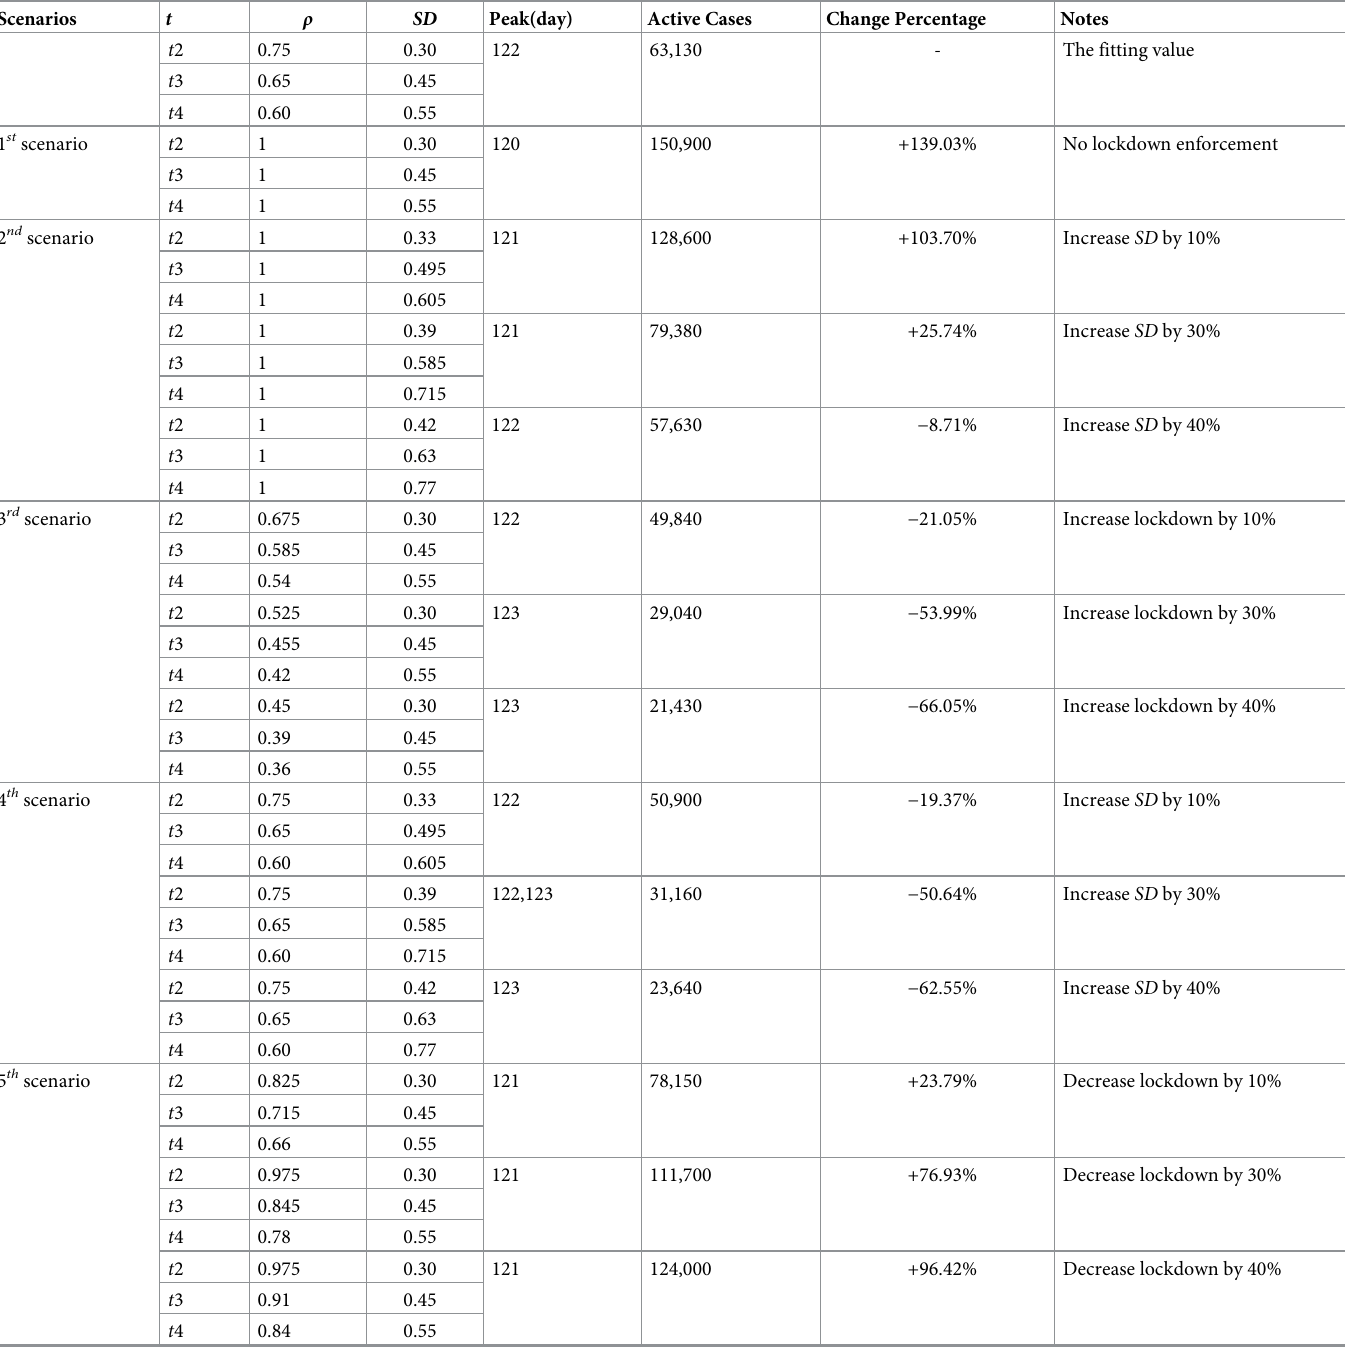
Table 5. Results of different scenarios for Phase 2, (1 st - 6 th )